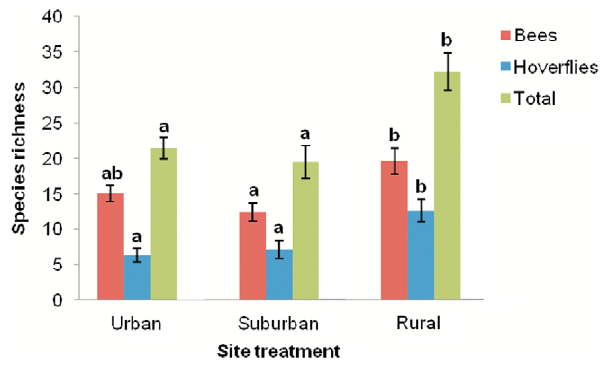
Figure 2. Relationships between site treatment and total species richness of bees, hoverflies, and total pollinators. Error bars = + / 2 1SE. Bars that do not share a letter showed significant differences ( P , 0.05) between treatments.